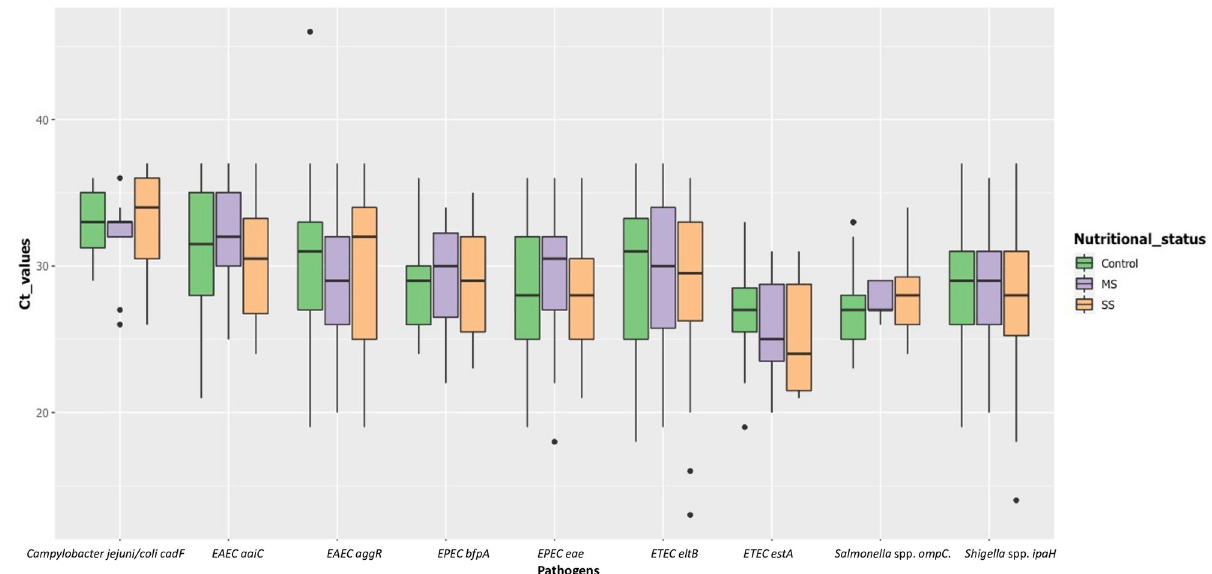
Fig 3. Box plot showing C T values for pathogens targeted by real-time PCR among stunted (104 moderately stunted and 96 severely stunted) and controls (N = 264). Boxes show the median (midline) and the 25 th and 75 th percentiles, and bars indicate the 10 th and 90 th percentiles. Only the positive subjects (C T values = < 37) for the respective pathogen agent was considered.